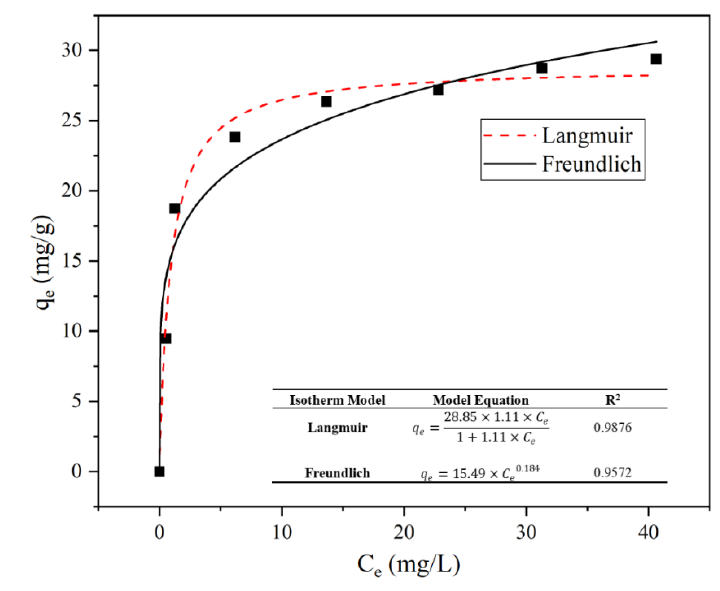
Figure 6. Isothermal fitting of Langmuir and Freundlich equations.